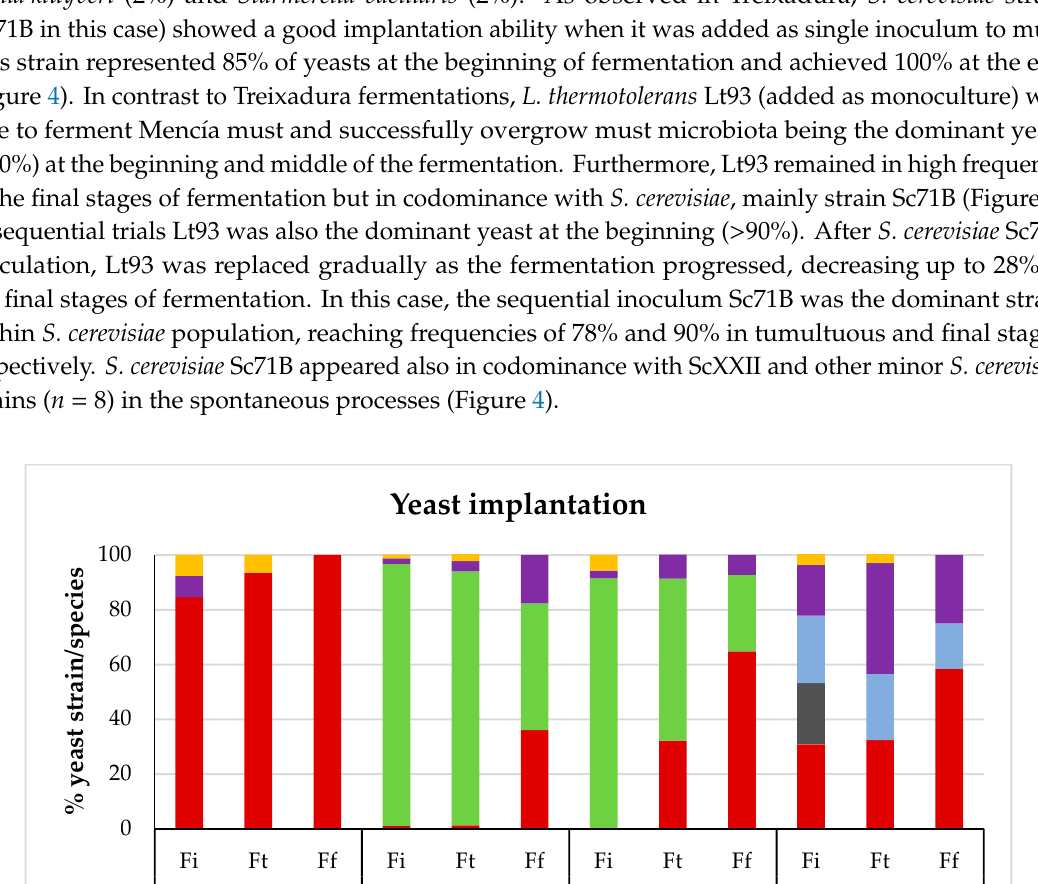
Figure 4. Inoculum implantation in Mencía fermentations: frequency of each inoculated yeast strain at initial (Fi), tumultuous (Ft) and final fermentation (Ff); Hu— Hanseniaspora uvarum ; Sc— S. cerevisiae ; spp—species.